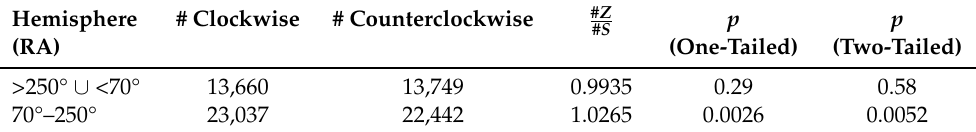
Table 10. The number of clockwise and counterclockwise galaxies in the exact same “clean” dataset of 72,888 galaxies used in [210]. The p values are the binomial distribution such that the probability of a galaxy to in a certain direction is random 0.5. The data are available at https://people.cs.ksu.